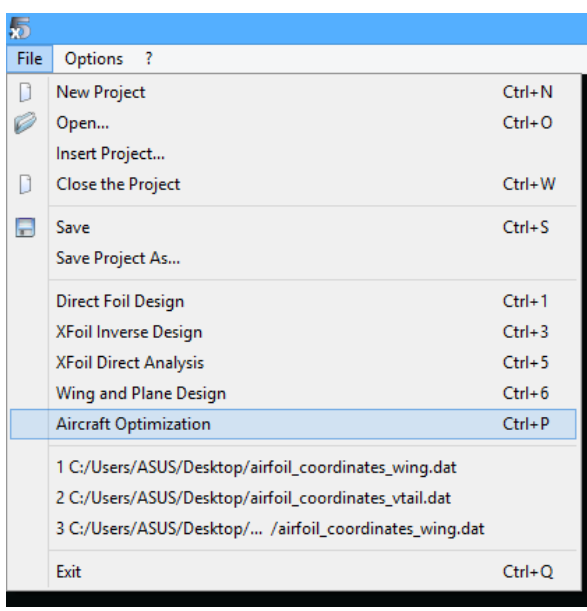
Figure 1: XFLR5 sub-menus.